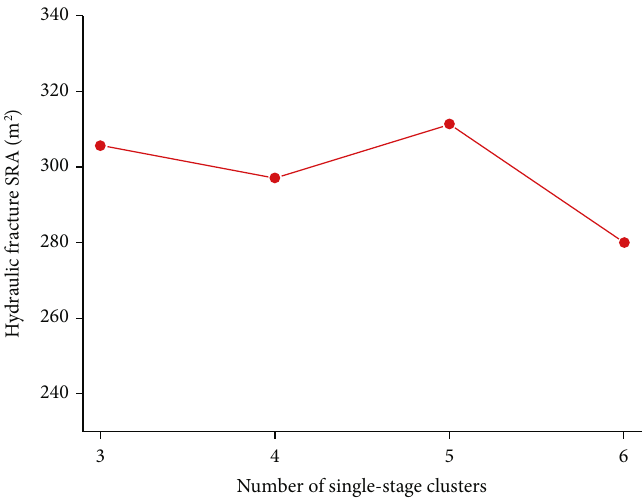
Figure 12: Hydraulic fracture SRA with di ff erent number of single-stage clusters.